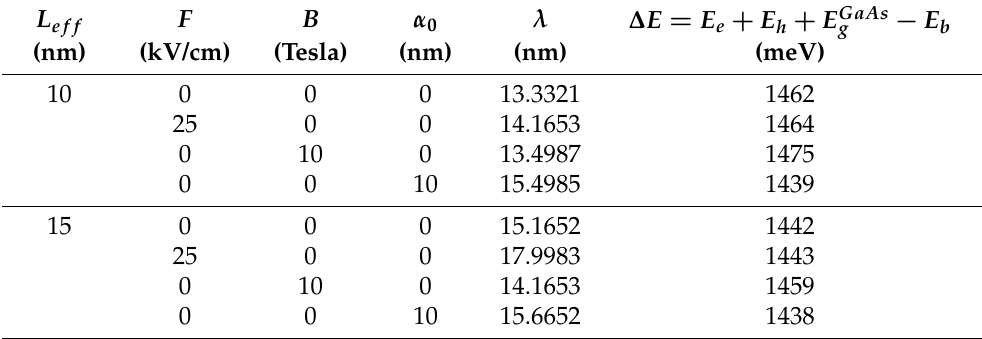
Table 1. The variations of λ and ∆ E parameters versus well sizes and external fields for V 1 ( z e ( h ) ) potential.